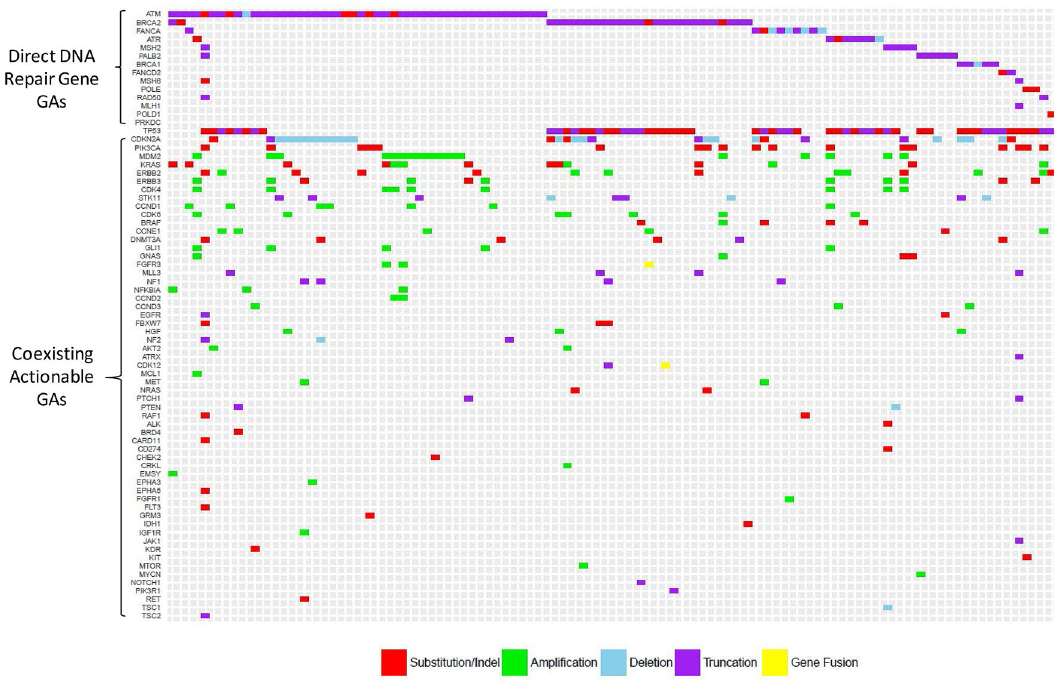
Figure 5. Tile plot for 109 gallbladder cancer patients with direct DNA repair genetic aberrations and coexisting actionable genetic